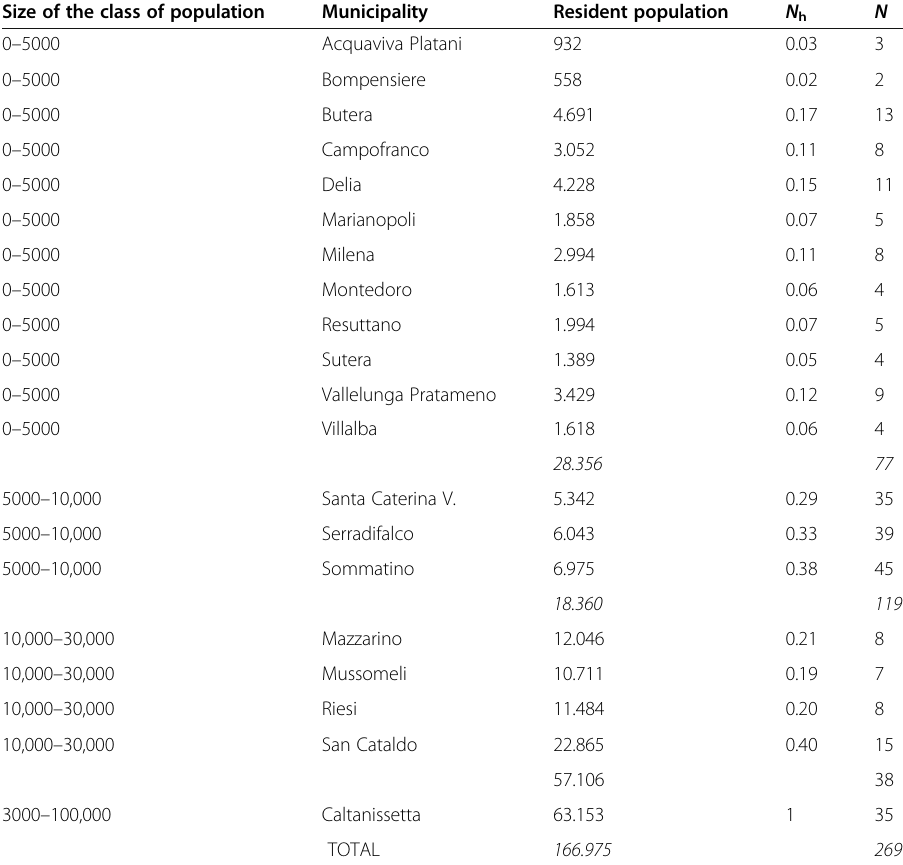
Table 4 First stage sampling. Attribution of the number of interviews for each municipality Size of the class of